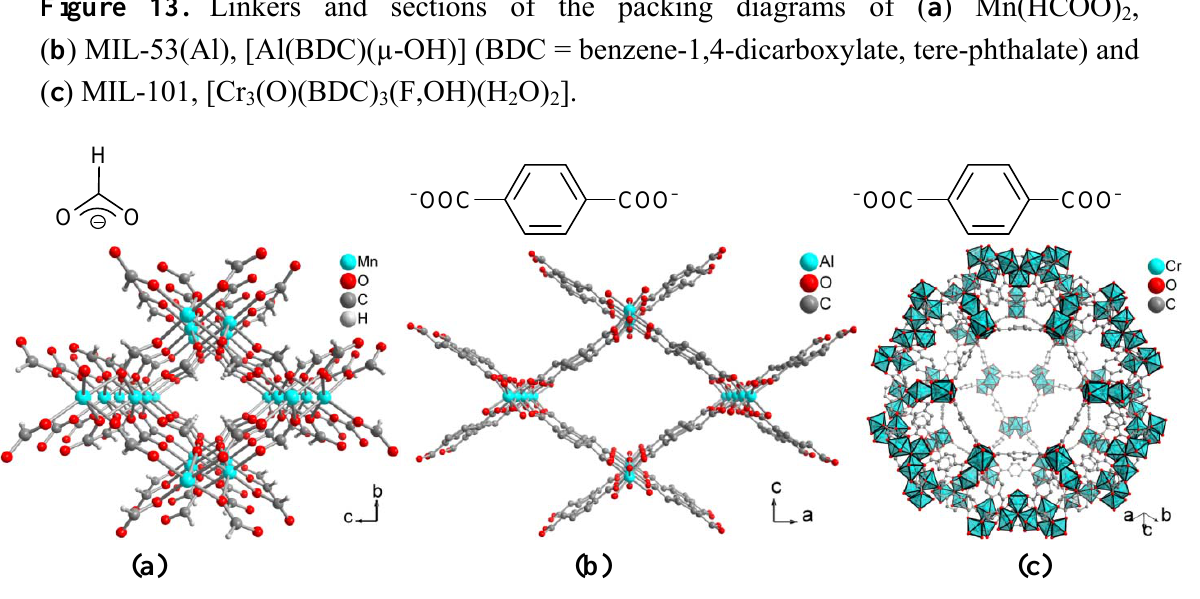
Figure 13. Linkers and sections of the packing diagrams of ( a ) Mn(HCOO)